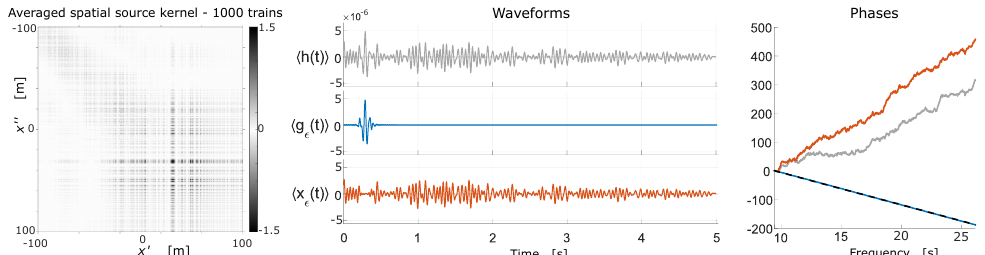
Figure 6. Example of a source signature from which the interferometric Green’s function estimate cannot be retrieved by stacking. The left panel shows the numerical/empirical approximation of the stacking average kernel (cid:104) ˆ F ∗ ˆ F (cid:105) ( x (cid:48) , x (cid:48)(cid:48) , ω ) in Equation (7) estimated by stacking 1000 trains of sources travelling at 90 km/h with an emitted spectrum between 10Hz and 25Hz. The receivers were placed perpendicularly to the source-line, with an inter-receiver distance of 200 m and the receiver closest to the source-line at a distance of 400 m. Away from the diagonal, non-zero elements persist. The middle panel shows the stacked waveform (cid:10) (cid:11) (cid:10) (cid:11) g (cid:101) ( t ) x (cid:101) ( t ) into and . The right panel shows the corresponding unwrapped phases for the full (cid:10) ˆ (cid:11) h ( ω ) term (gray) and its decomposition into the (cid:101) -diagonal term (cid:11) (cid:10) ˆ x (cid:101) ( ω ) term and (orange), as well as the phase of the inter-receiver Green’s function (dashed black) estimated from discrete sources as per Equation (1) as a reference. In this case, the stacking average (cid:10) ˆ (cid:11) ( F ∗ ˆ F x (cid:48) , x (cid:48)(cid:48) , ω ) in Equation (7) is not localized and the value of the correlation length cut-off kernel (cid:101) was chosen according to the approach described in Section 4. The phase retrieval from and ˆ g (cid:101) ( ω ) is similar and not